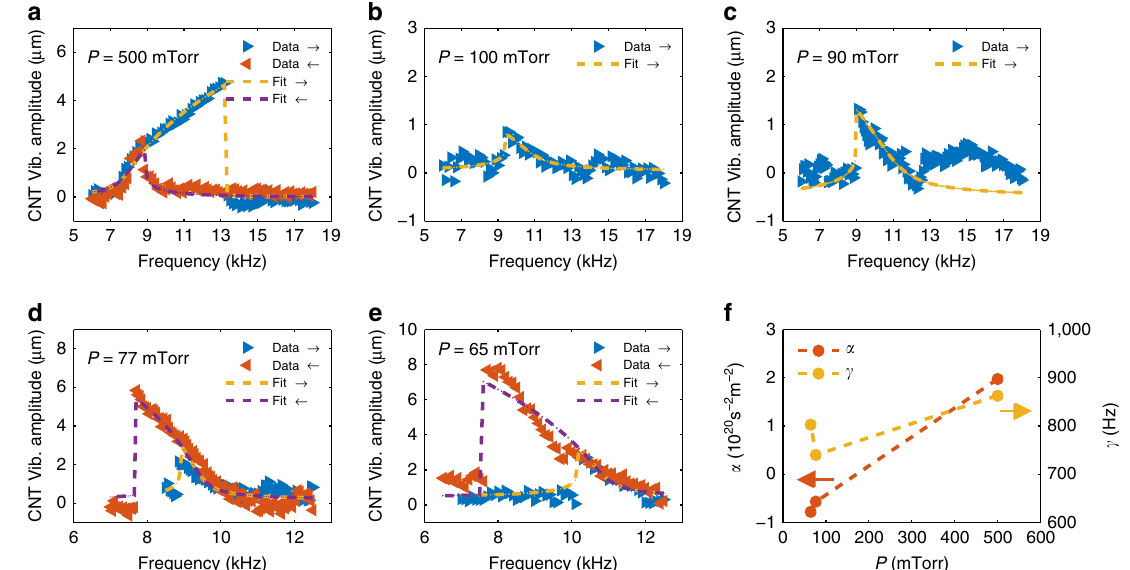
Figure 6 | Hardening to softening behaviour. ( a – e ) Amplitude of vibration of carbon nanotube (CNT) versus excitation frequency for different pressures, as marked inside each panel. Blue triangles are data for up sweep and red triangles for down sweep. The yellow and purple dashed lines are the theoretical solutions according to Supplementary Equations 33 and 34, for up and down sweep, respectively. ( f ) Left axis: Extracted non-linear spring constant, a , as function of pressure. Right axis: Extracted coefficient of linear damping, g , versus chamber pressure. Vib.,